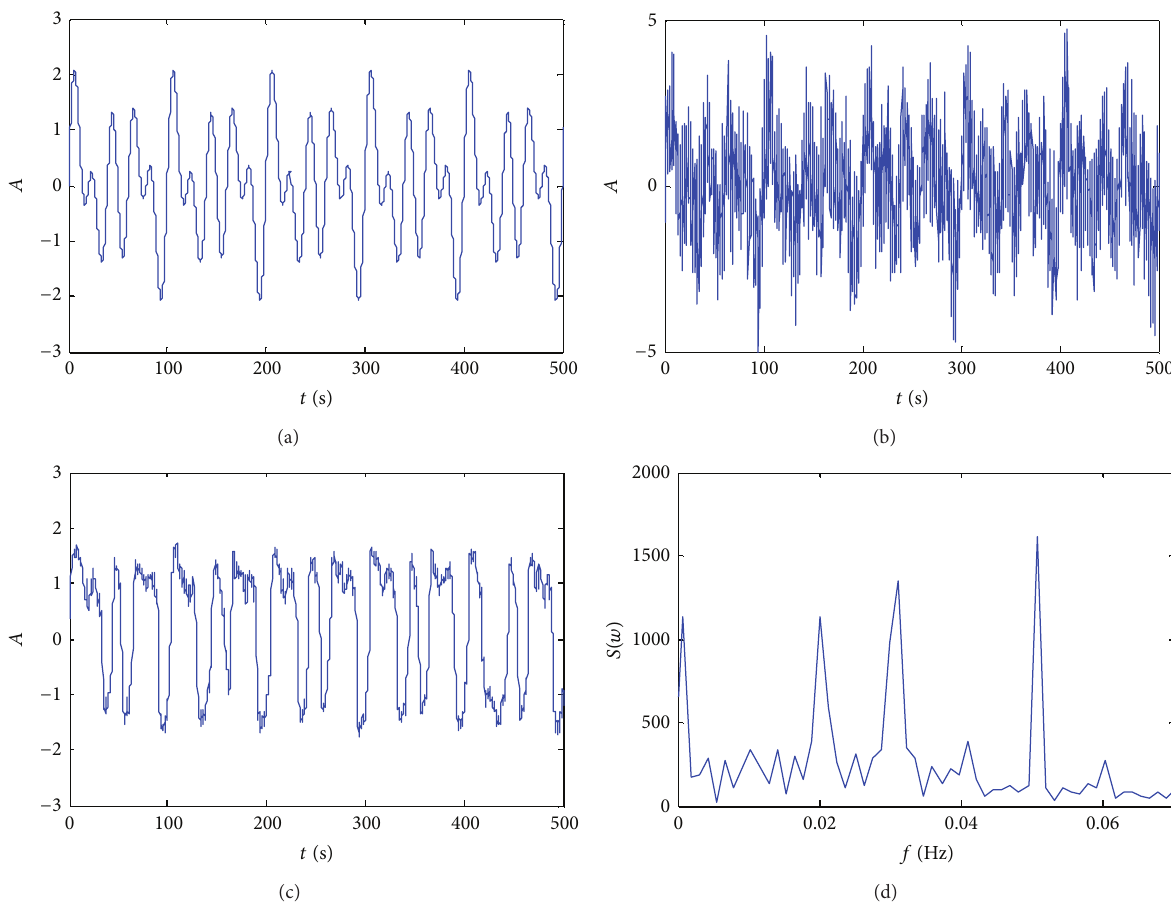
Figure 5: (a) The multi-frequency input signal to be measured. (b) The multi-frequency input signal to be measured contains white Gaussian noise. (c) The stochastic resonance output signal. (d) The spectrum figure of the stochastic resonance output signal.